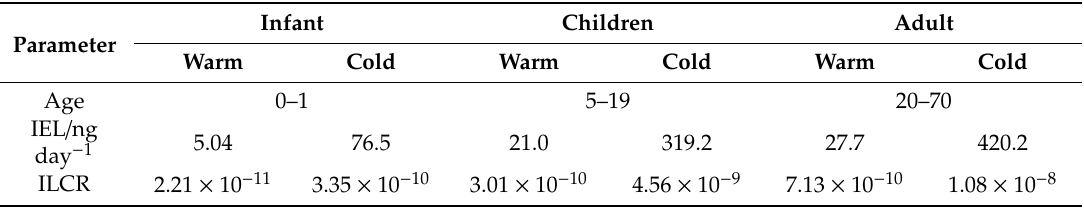
Table 5. The BaPeq daily dose (IEL) and the incremental lifetime cancer risk (ILCR) for three age groups. Infant Parameter